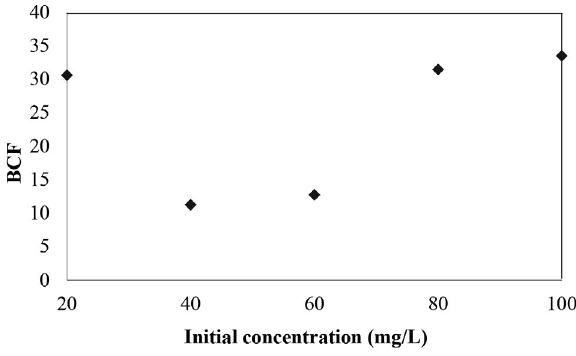
Figure 11. Bioconcentration factor (C i = 20–100 mg/L, 1.5 g adsorbent, 160 µm, 700 rpm, pH = 6.0 ± 0.2, T = 20 ± 1